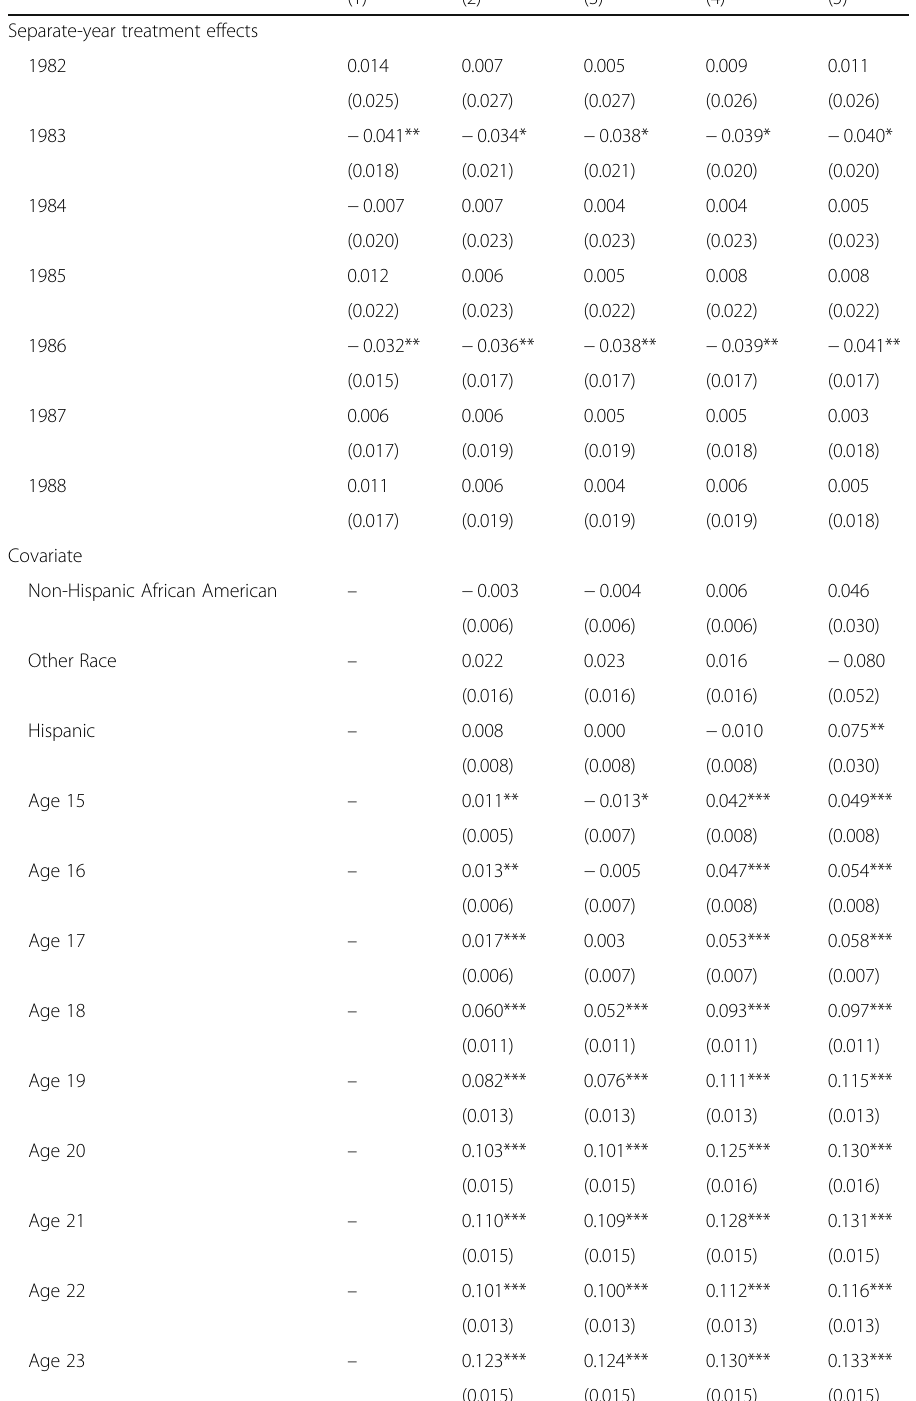
Table 6 Full set of coefficient estimates for Table 4